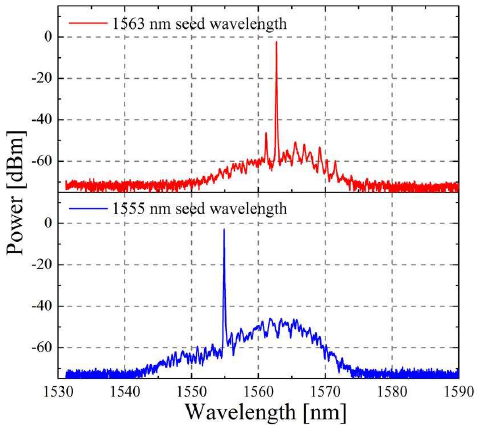
Figure 7. Optical spectra of the output signal at the wavelengths of 1555 nm and 1563 nm.